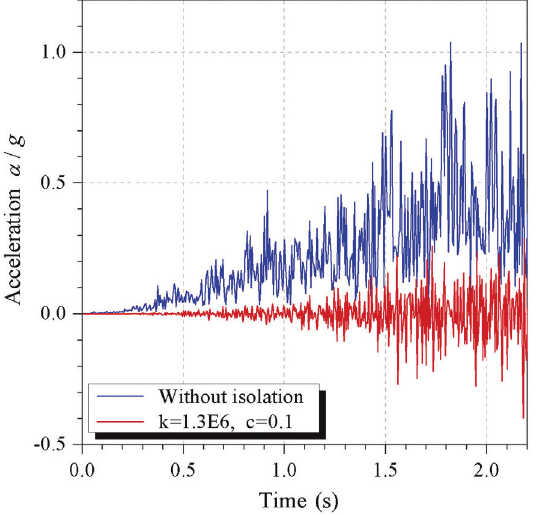
Figure 9: Typical model of the